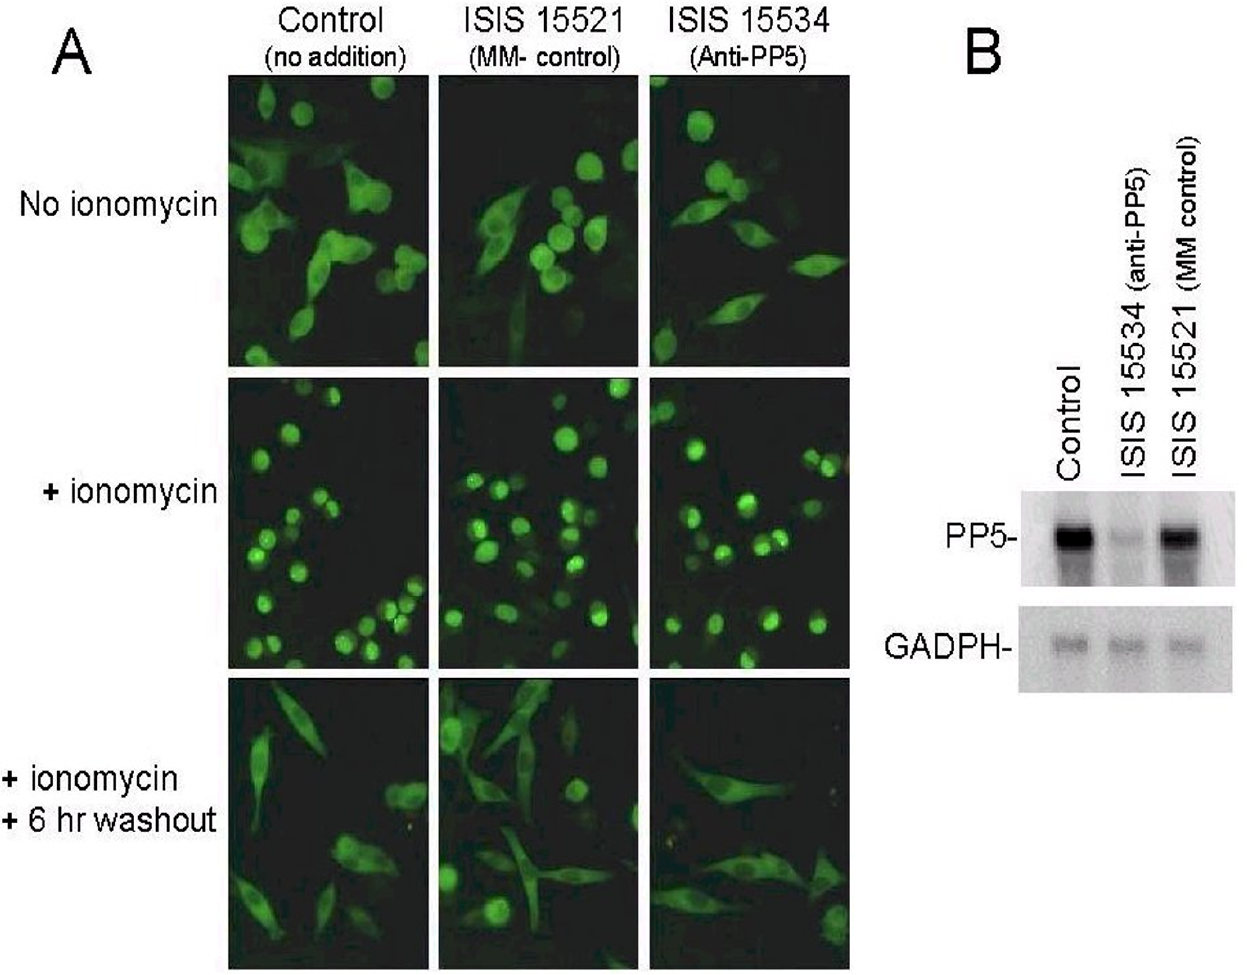
Figure 3 Nucleo-cytoplasmic shuttling of GFP-NFAT. A) GFP-NFAT expressing HeLa cells were grown on glass coverslips and either left untreated (control) or treated with ISIS 15534 or the mismatched control (ISIS 15521) as described in Materials and Methods. Twenty-four hours after oligonucleotide treatment, the cells were either directly fixed with paraformaldehyde (No ionomycin), or ionomycin was added to 1 µ M for 30 minutes. After treatment with ionomycin, the cells were either fixed (+ ionomycin) or rinsed in PBS and grown for an additional 6 hours in medium in the absence of drug (washout) before fixing. Representative fields of cells were viewed by fluorescence microscopy and photographed. B) . Northern analysis of HeLa cells following treatment with 500 nM ISIS 15534, 500 nM ISIS 155521 or lipofectin alone (control), probing for PP5 and GAPDH confirms that the antisense oligonucleotides are also effective HeLa